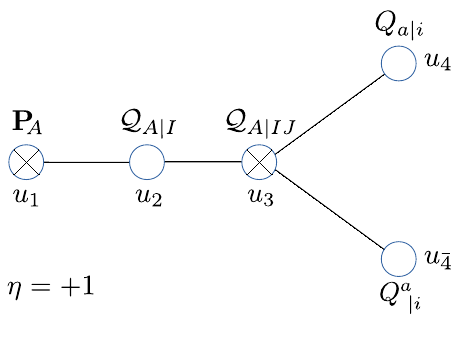
Figure 5 . Chain of Q functions corresponding to the (cid:17) = +1 grading of the Bethe Ansatz. Q , Q , Q a , together with the relations linking them, equations (4.4), (4.5), (4.8). I a j i j i